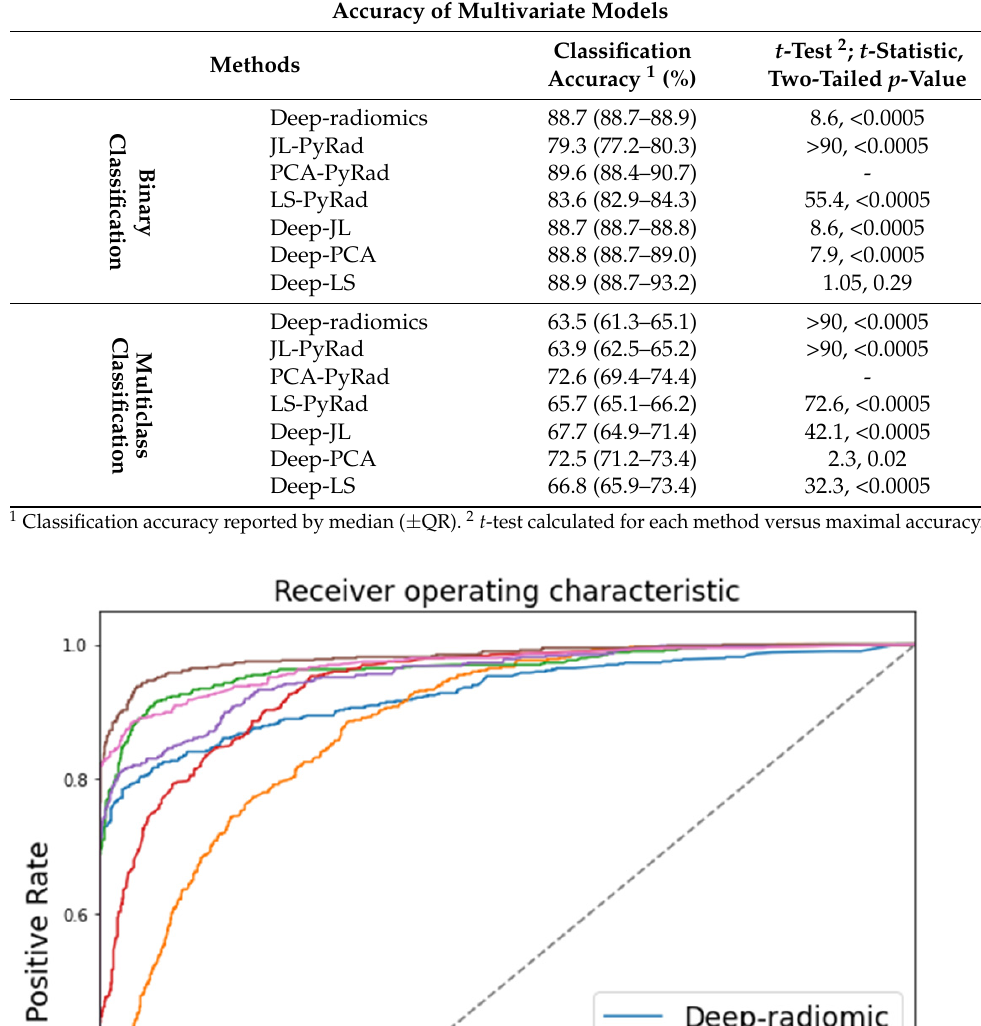
Table 2. Results of diagnosis based on the classification of symptomatic versus asymptomatic patients with the leave-one-out cross-validation.